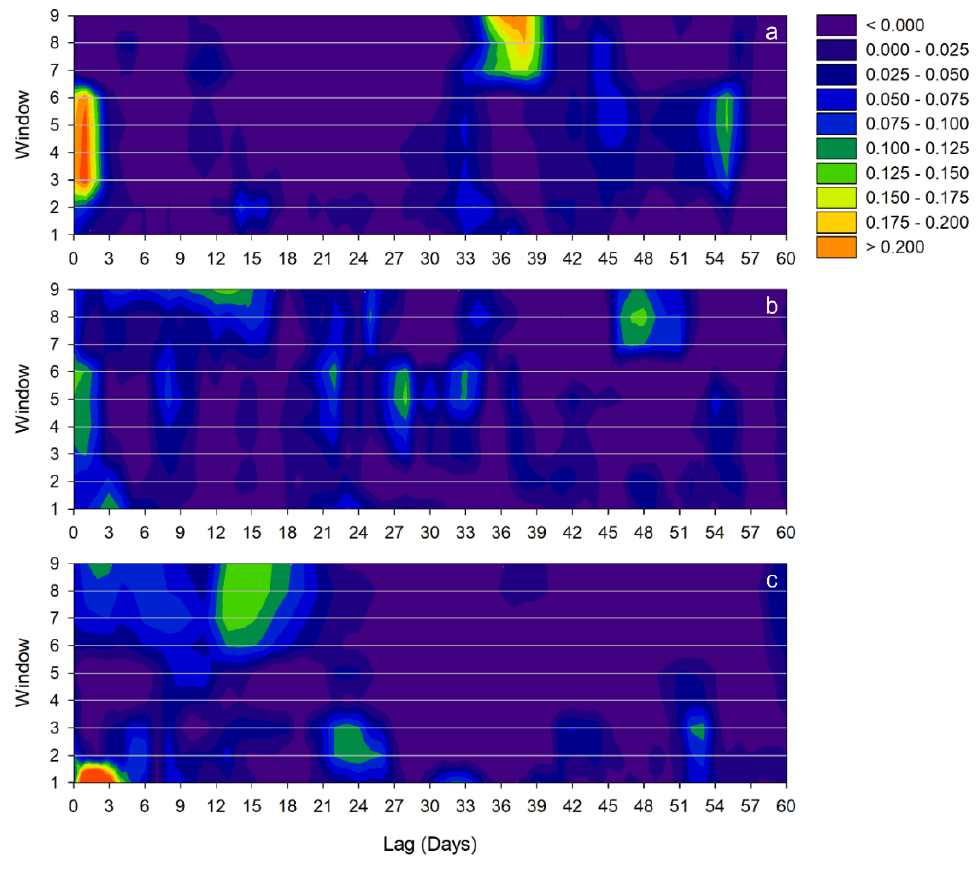
Figure 5. Contour graphs that represent variations in the curve shape of the high-elevation rainfall/residual spring discharge CCFs, over the whole period (i.e., among the sliding windows shown in Table 5). ( a ) MTPr/resPES; ( b ) MTPr/resCD; ( c ) MTPr/resFOC. The positive correlation value corresponding to the 95% significance level ( p < 0.05) is 0.06. corresponding to the 95% significance level ( p < 0.05) is 0.06. Table 5. List of windows considered in the Sliding-Window Cross-Correlation Function (SWCCF) analysis, with the corresponding starting and ending dates. The Co-seismic period refers to windows that include in the part of time-series at least one of the main shocks occurred in the 2016–2017 series of strong seismic